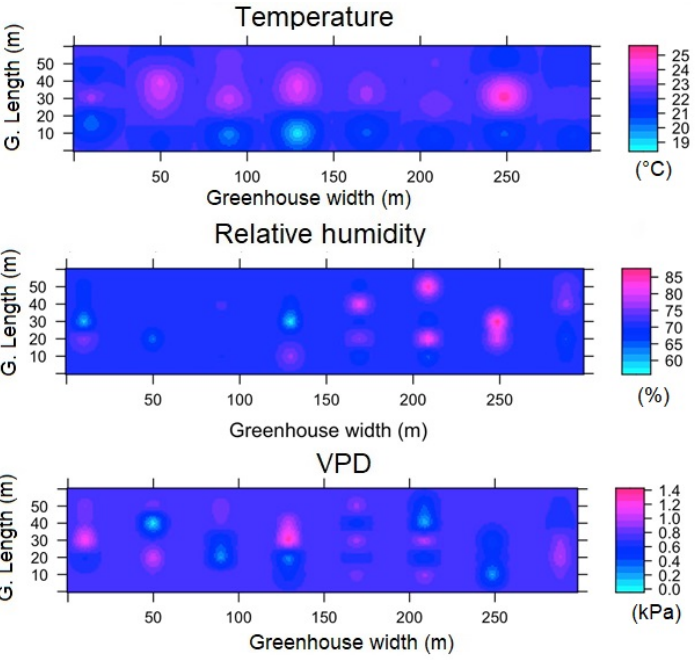
Figure A9. Spatial distribution predicted by kriging, for temperature, relative humidity and VPD in SG and for ESRL 4.